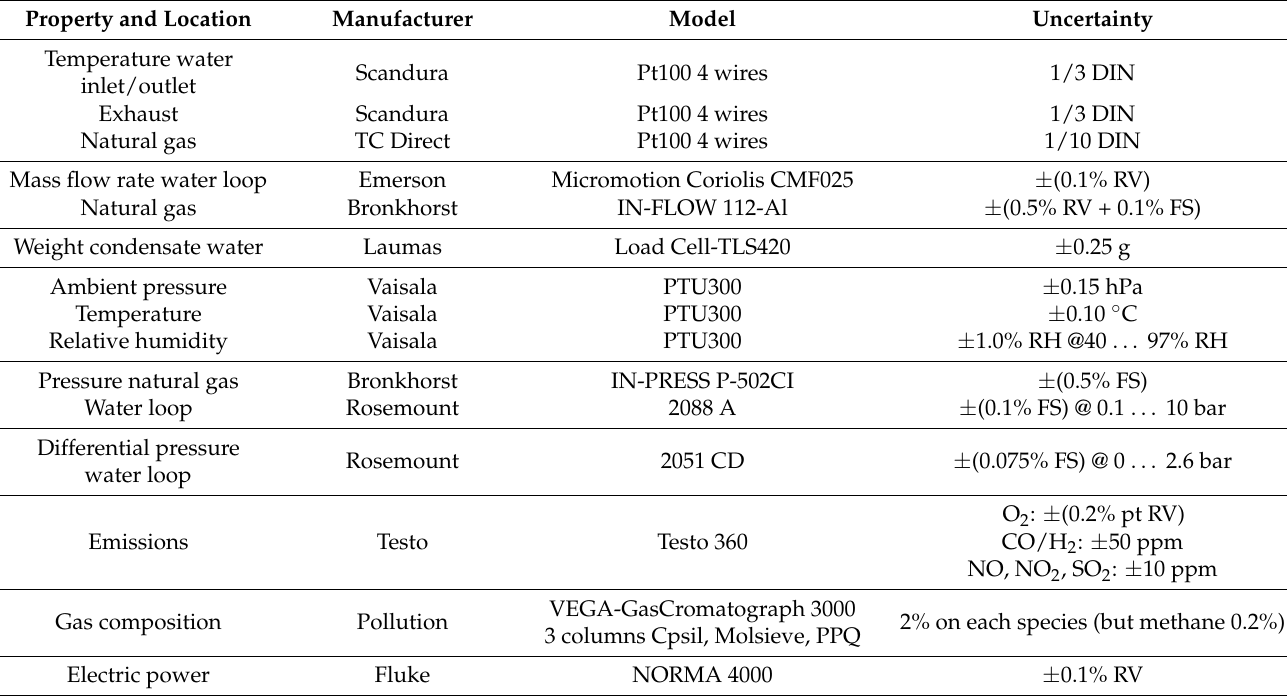
Table 1. Instrumentation list complete of manufacturer, model, and uncertainty (FS stands for full scale, RV for read value) employed in the experimental